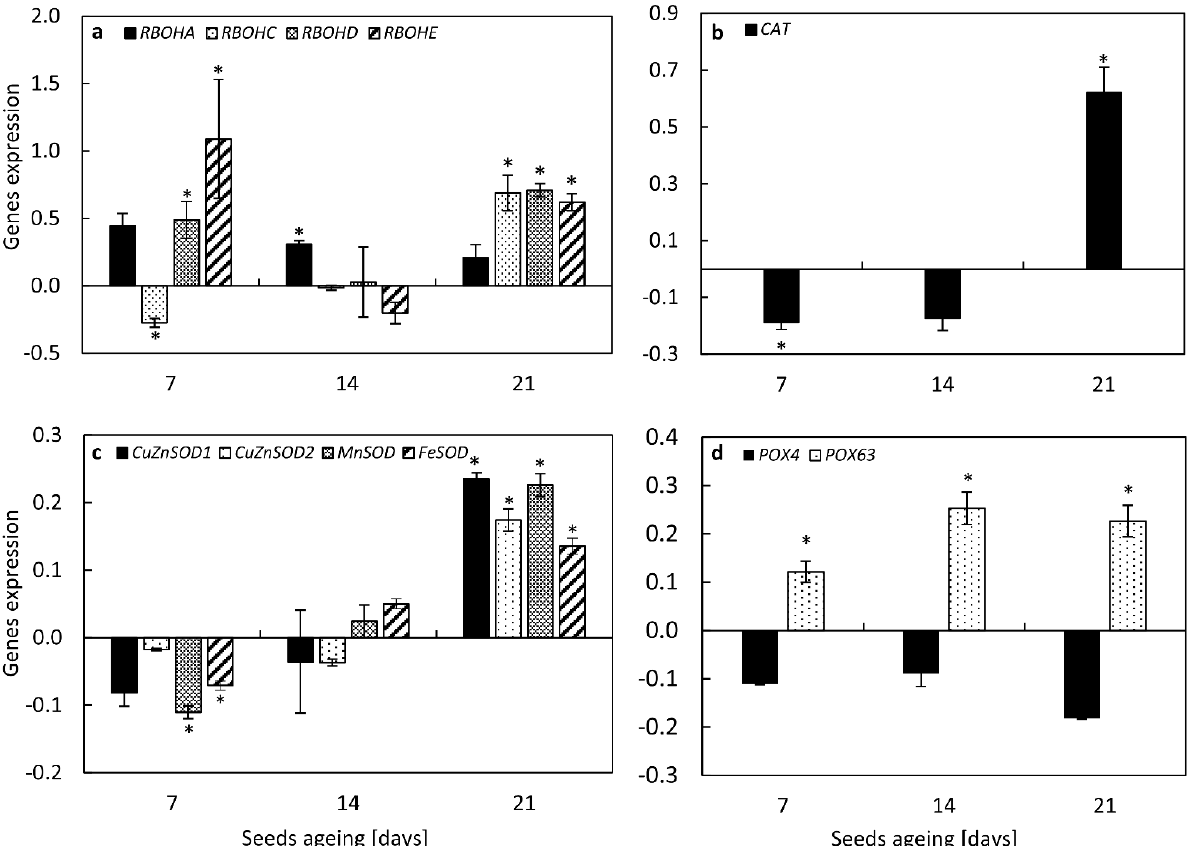
Figure 8. The relative transcript levels of genes encoding RBOH homologues ( a ) RBOHA , RBOHC, RBOHD , RBOHE , ( b ) CAT , ( c ) CuZnSOD1 , CuZnSOD2 , MnSOD , FeSOD and ( d ) POX4 , POX63 in the axes of apple seeds subjected to accelerated ageing for 7, 14, and 21 days, treated with NO, analyzed by qRT-PCR as described in the section of Material and Methods. Values are average ± SD of 3–5 repetitions. Asterisks indicate significant differences between the treated sample compared to the adequate control sample, obtained by the Student test ( p < 0.05).